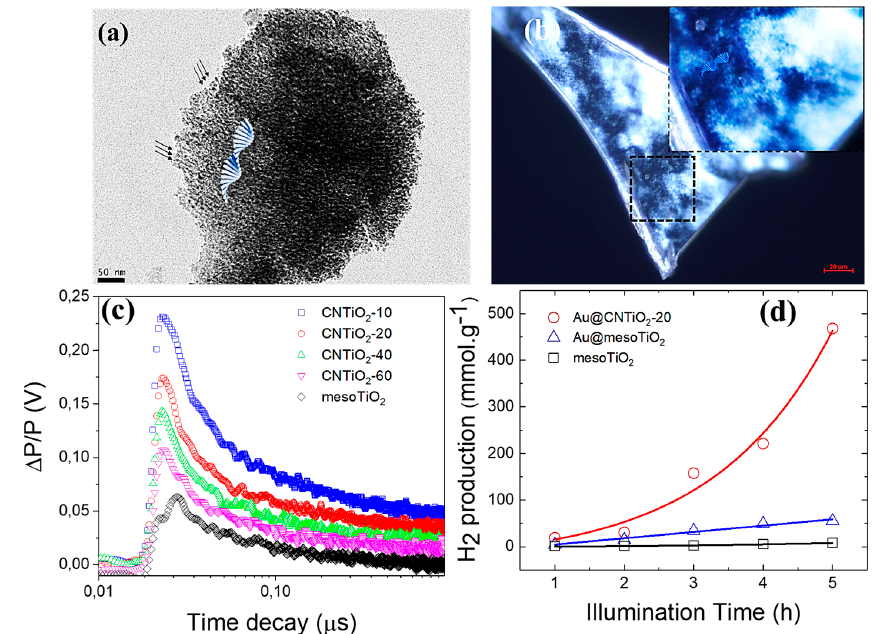
Figure 11. ( a ) Simplified scheme of optical photonic band gap of a photonic crystal; ( b ) the velocity of light slows down at the lower photon energy edge (red edge) and at the higher photon energy edge (blue edge) of the Bragg peak reflection (forbidden wavelength). Adapted with permission from [49]; ( c ) low-magnification and ( d ) high-resolution SEM images of ordered Au / TiO 2 inverse opal film; ( e ) reflectance spectra showing the Bragg peak reflection maxima obtained for di ff erent samples compared to the absorbance spectra of TiO 2 ; ( f ) photocatalytic rate of hydrogen and oxygen generation over variable photocatalysts. Adapted with permission from [59].